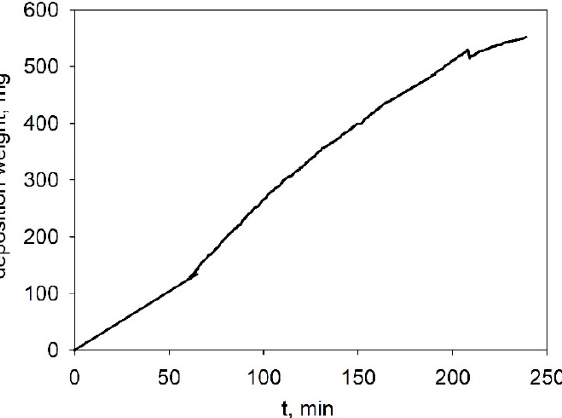
Figure 4. Kinetics of the green body growth vs. duration of the EPD from a YLO_iA_1 suspension at a constant electric field of 20 V/cm.